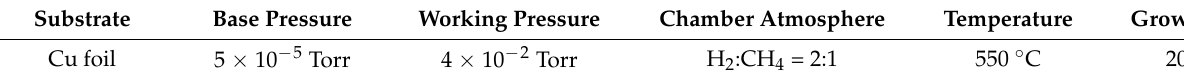
Table 1. Conditions for growing CNW via PECVD.